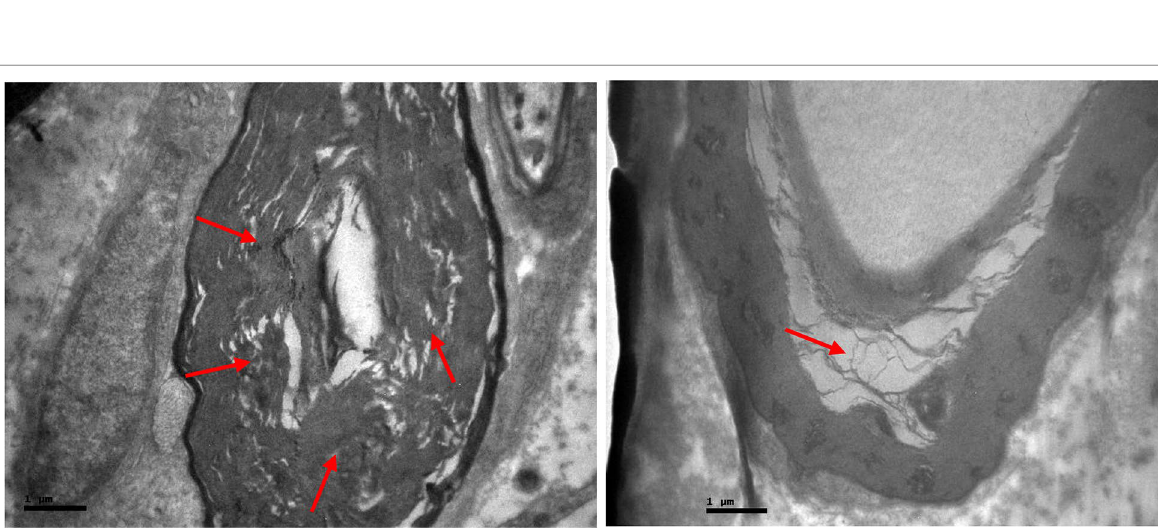
Fig. 4 Effects of alendronate on femoral nerve of research group. Myelin partial disorganisation and vacuolization (red arrow)